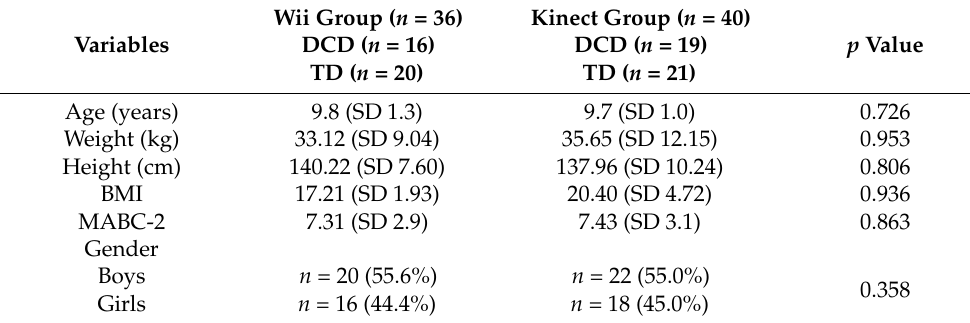
Table 1. Descriptive data of participants between Wii and Kinect